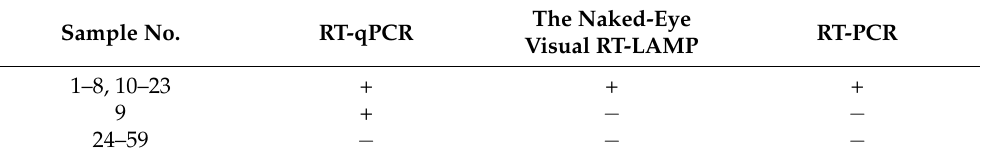
Table 3. Results of 59 clinical samples tested by the naked-eye visual RT-LAMP, RT-PCR, and RT-qPCR for FMDV